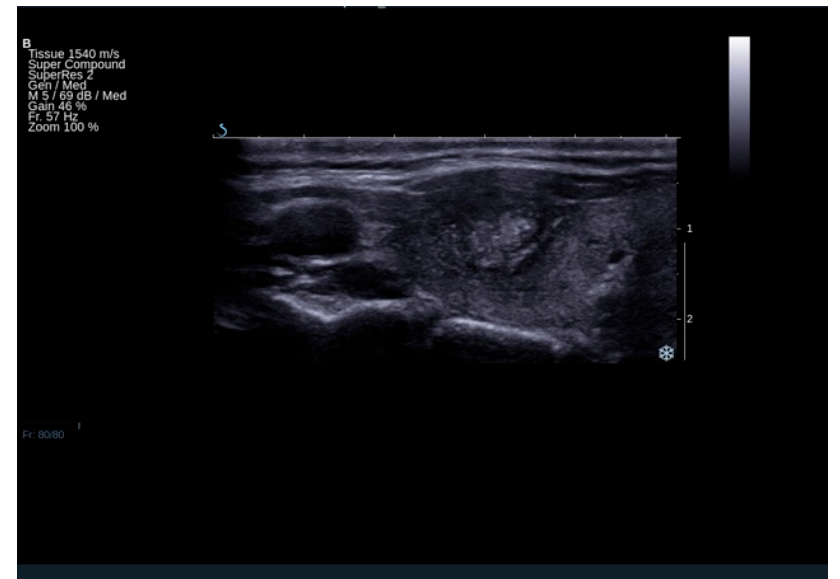
Figure 3. The result of ultrasound examination demonstrating thyroid lesion, which turned out to be follicular cancer on histopathological examination. The lesion presents tumor protrusion, irregular margins, microcalcifications, and heterogeneous echostructure.